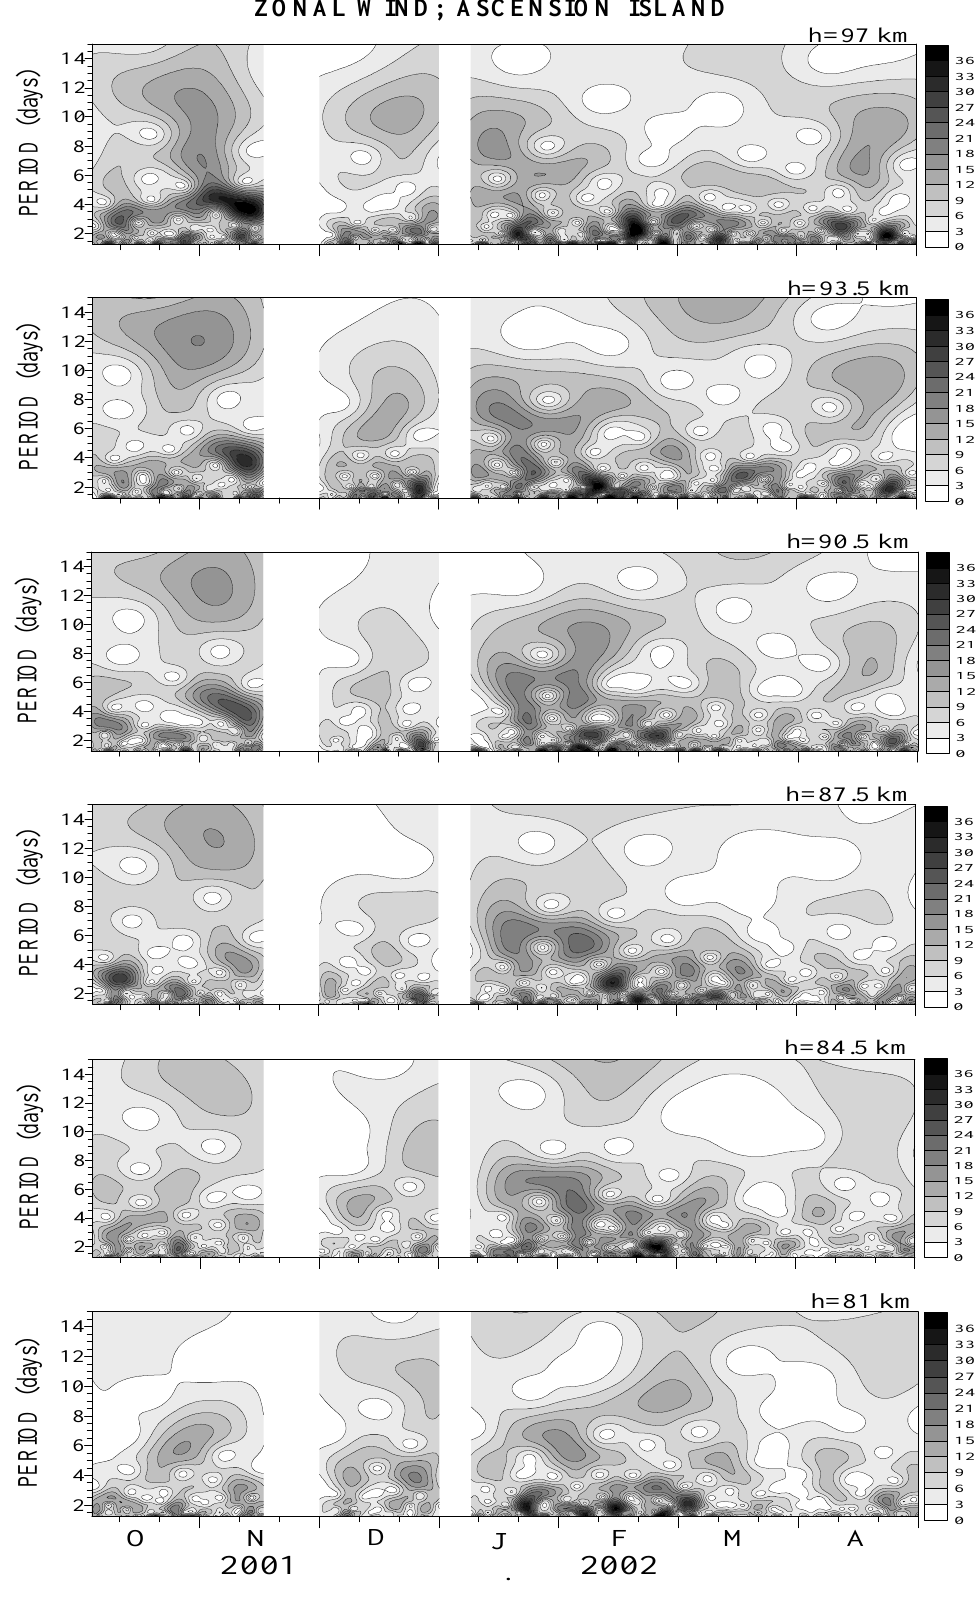
Fig. 2a Fig. 2a. Wavelet transform of the zonal wind observed by meteor radar in the interval 05 October 2001–30 April 2002. The spectra are calculated in the period interval 1.5-15 days and for six altitudes shown on the right upper corner of each